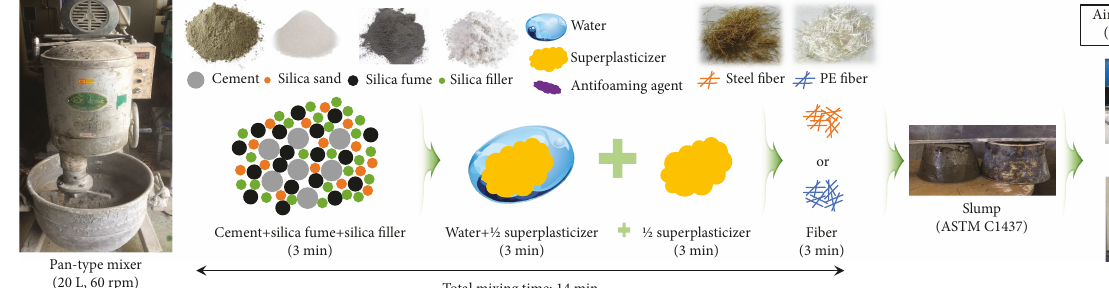
Figure 1: Mixing, curing, and test method of